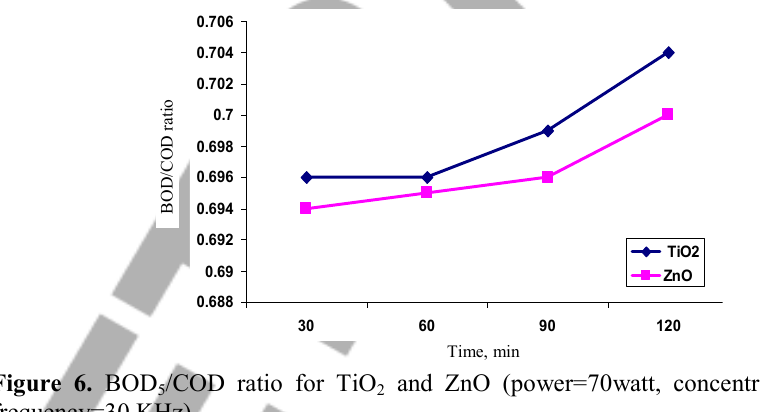
Figure 6. BOD /COD ratio for TiO 5 frequency=30